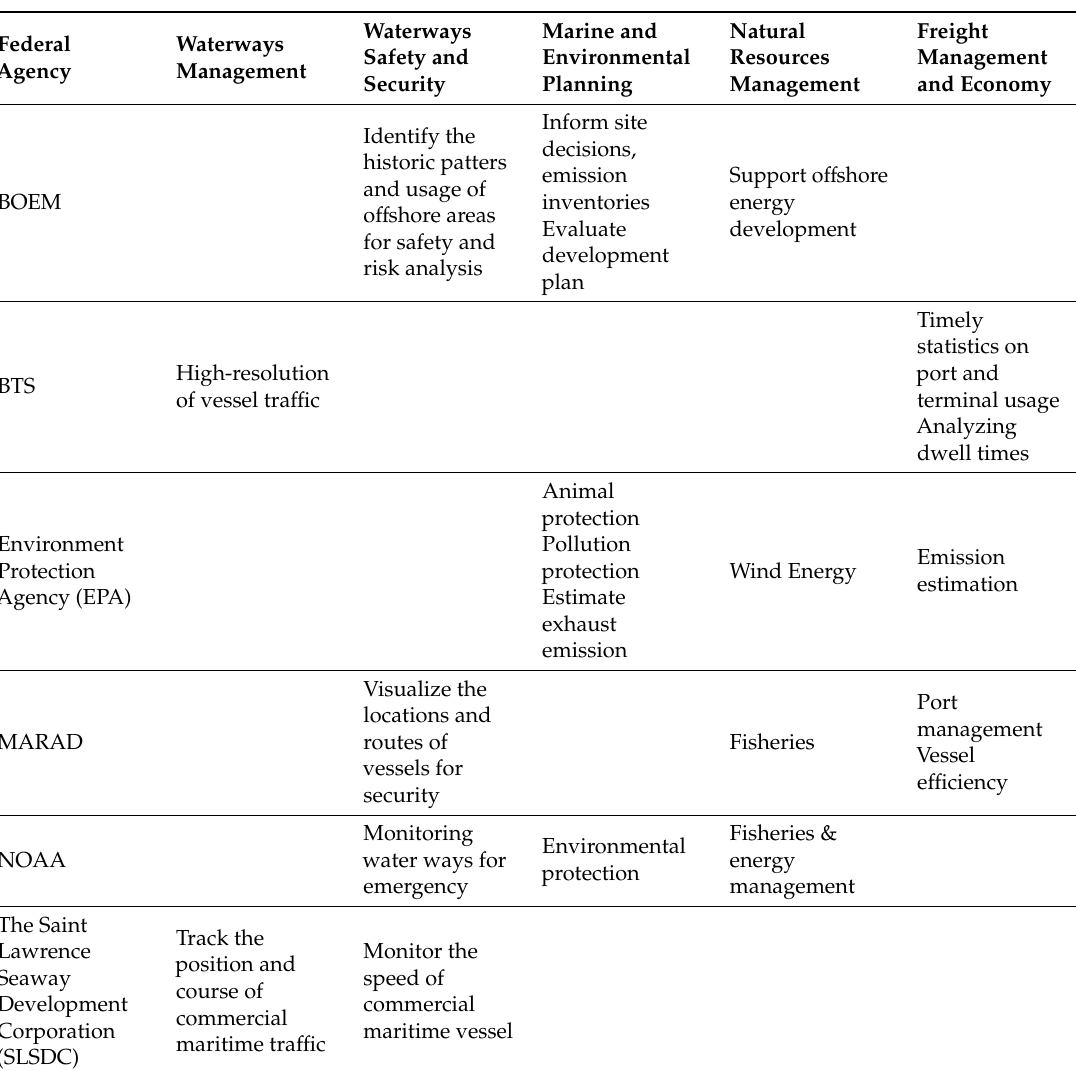
Table 1. Agency applications of AIS